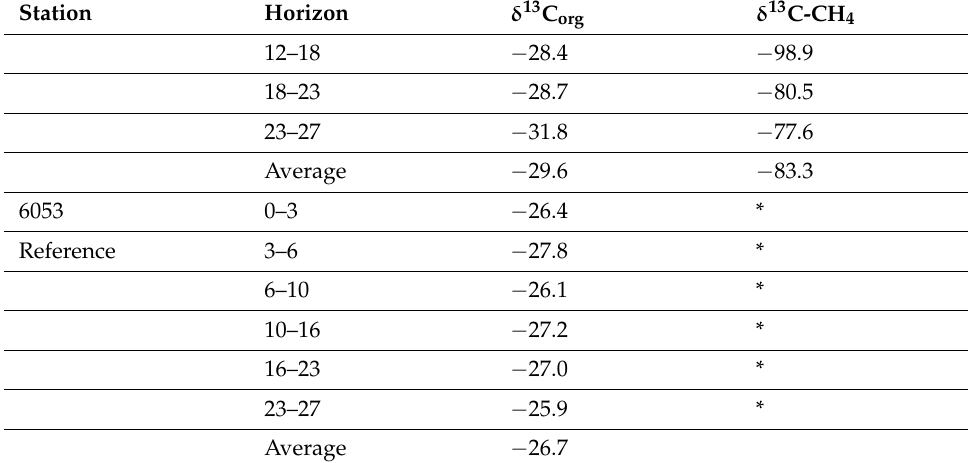
Figure 10. Rates of methane oxidation (M О , nmol dm ‒ 3 day ‒ 1 ) in the Laptev Sea shelf sediments. Methane carbon oxidation to СО 2 and assimilation into organic matter of microbial biomass and dissolved organic carbon (BM + DOC). The rates of sulfate reduction in the sediments of two seep stations, st. 6027 and st. 3–7 cm horizon and regularly decreased in deeper layers. The SR rate in the sediments of the reference station was five times lower (from 0.3 to 1.0 µmol dm − 3 day − 1 ). Sulfate reduc- tion resulted in a reduction of sulfate sulfur to sulfide (55 to 80%) and to combined pyrite, elemental, and cellular sulfur. No visible patterns were revealed in the distribution of re- duced sulfur species at different stations and in different horizons.